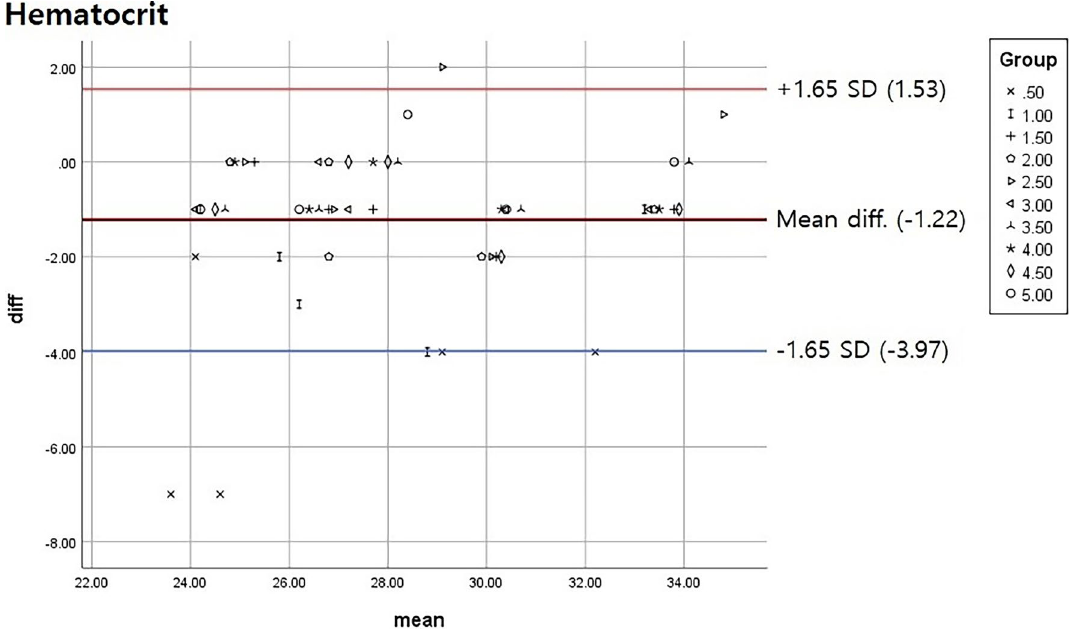
Figure 2. Hematocrit results for each clearing volume group. Results from all groups were within the 90% confidence interval after removal of the 2.5 mL group (Total n = 50). SD standard deviation, diff difference.